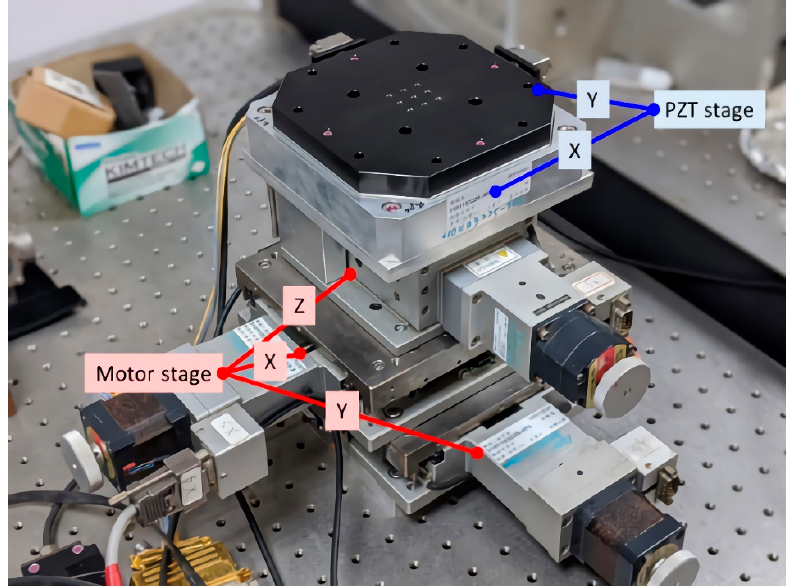
Figure 4. The long-stroke precision stage. Table 1. Specifications of the long-stroke precision stage.